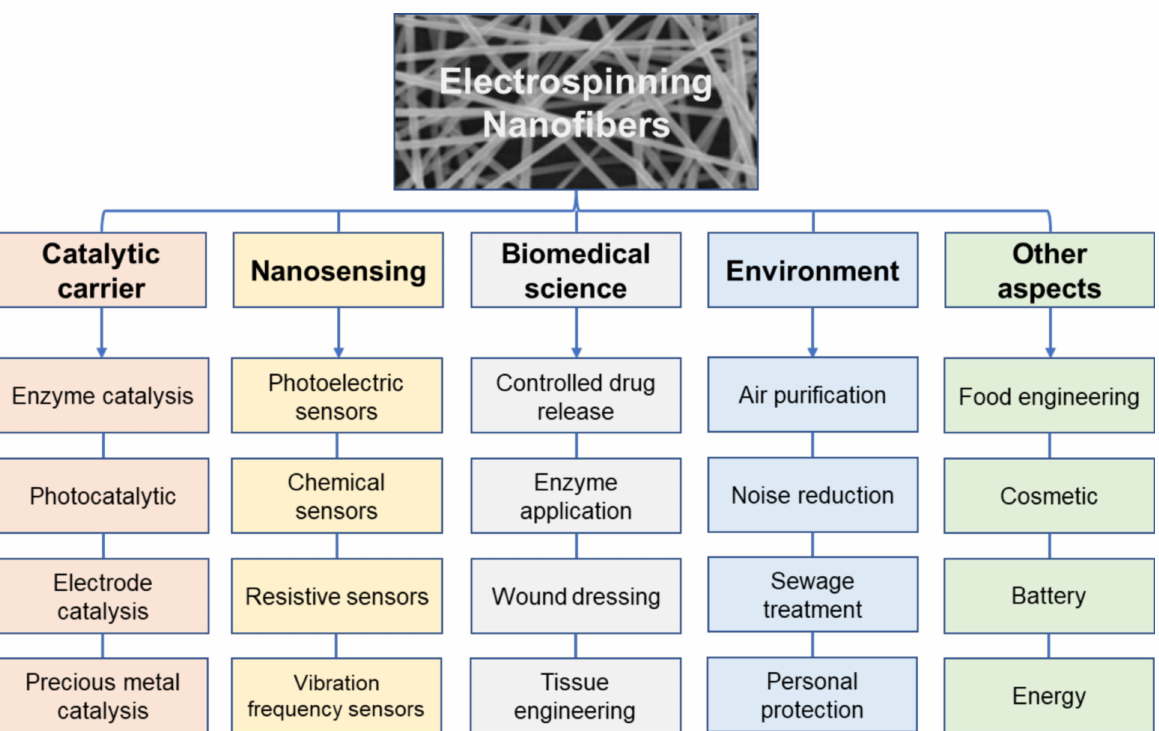
Figure 3. Applications of Electrospinning